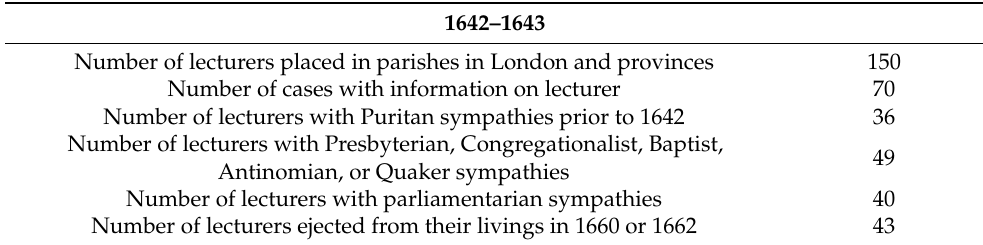
Table 3. Religious and Political Outlook of